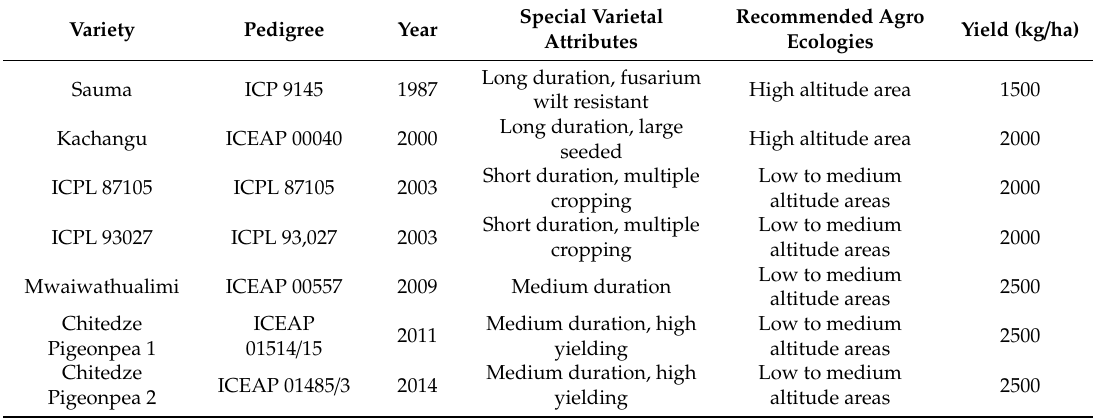
Table 8. Pigeonpea varieties released in Malawi and their characteristics.